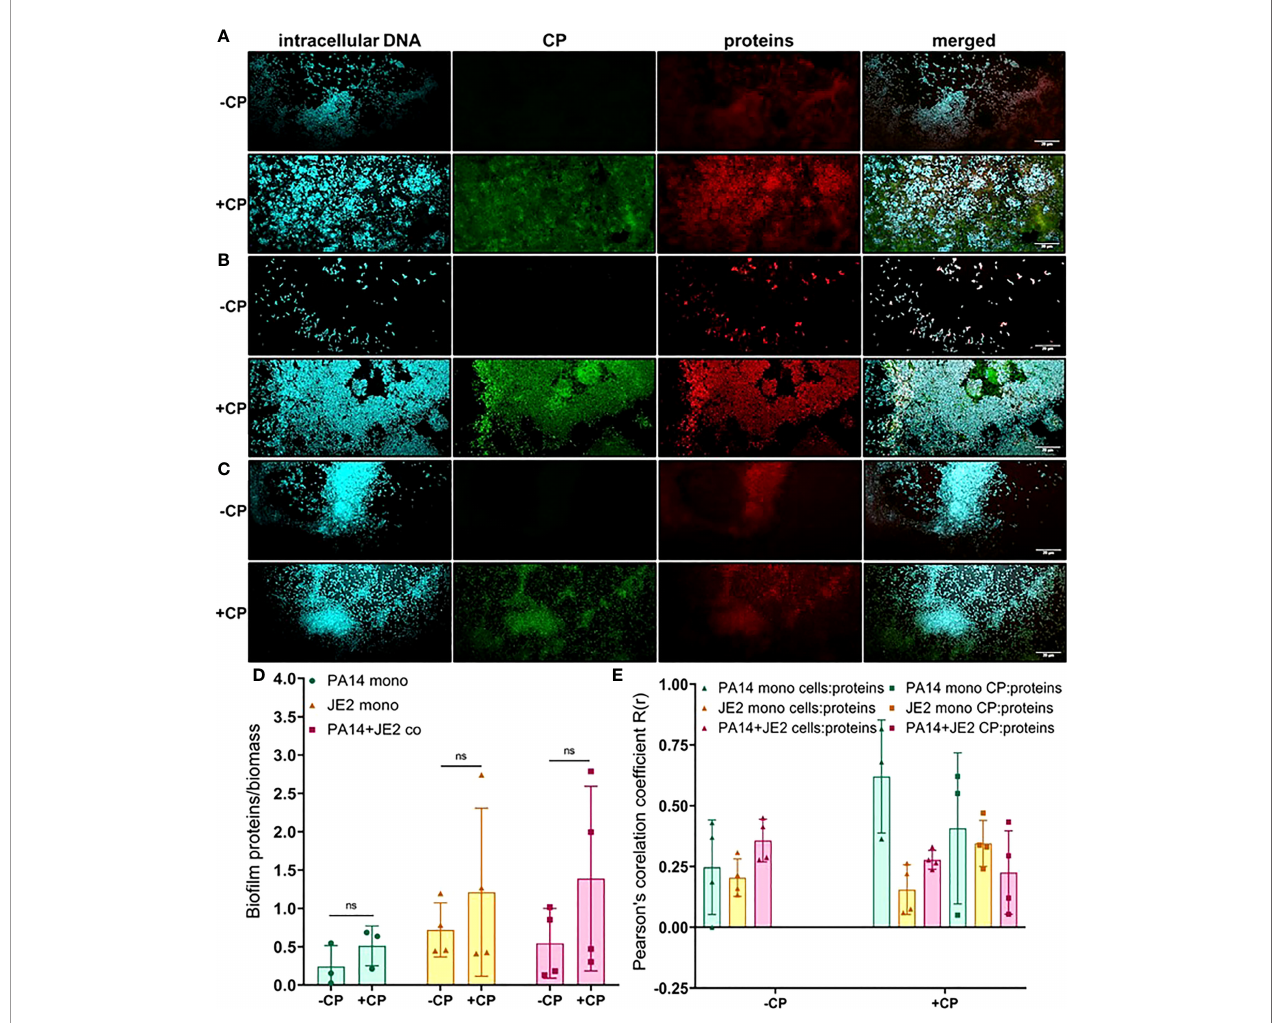
FIGURE 5 | Addition of CP correlates with subtle increase in the protein component of bio fi lm matrices. This fi gure depicts confocal images that represent abundance of proteins in P. aeruginosa and/or S. aureus bio fi lm communities in presence or absence of CP conditions. The fl uorescence dyes Hoechst 33342, Alexa 488, and SYPRO Ruby correspond to intracellular DNA of microbial cells, CP, and matrix proteins in the bio fi lm EPS of- (A) P. aeruginosa monoculture (B) S. aureus monoculture (C) P. aeruginosa - S. aureus co-culture. (D) Quanti fi cation of proteins per biomass in P. aeruginosa and S. aureus bio fi lms in presence or absence of CP. (E) Colocalization analysis of protein signals with cells and CP show similar distribution of protein signals around cell signals and CP signals. Images show 100X magni fi cation and were processed using ImageJ. Bars represent the mean offour biological replicates performed on two independent days. Error bars represent the standard error of mean of the biological replicates. Unpaired t-test (two-tailed) was used to measure statistical signi fi cance. Comparisons marked ns denote changes that were not found to be statistically signi fi